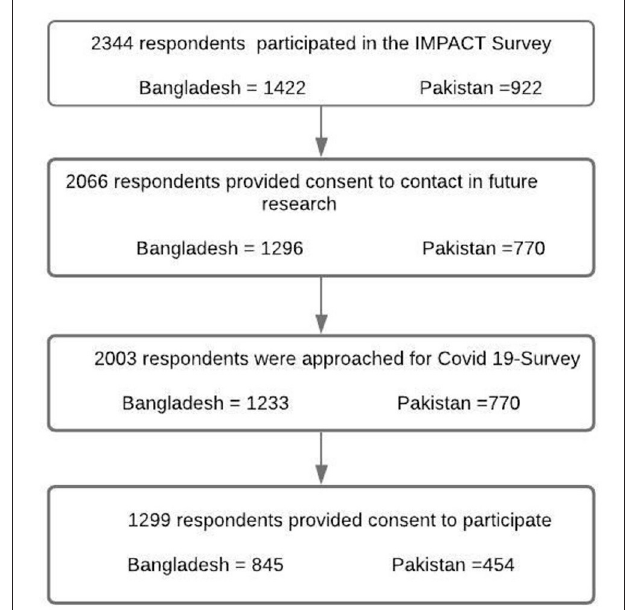
FIGURE 1 | Participant flow chart across the two